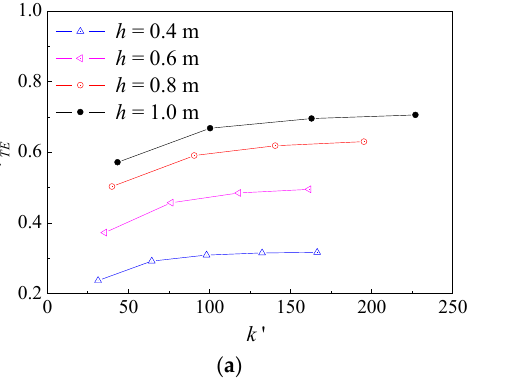
Figure 21. The change in thrust enhancement ratio and resistance reduction ratio of bow foil with different spring stiffness and different spans. ( a ) Thrust enhancement ratio r TE . ( b ) Resistance reduction ratio r R .